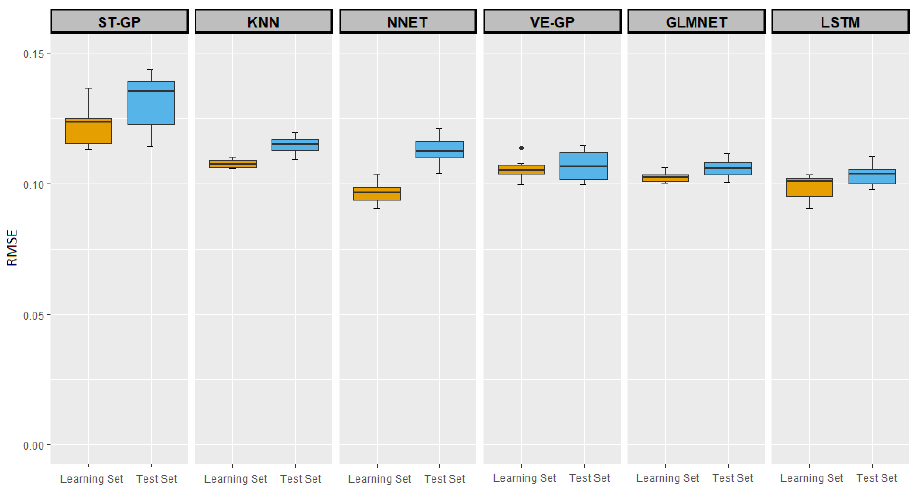
Figure 2. RMSEs on both the learning and test sets for the different algorithms. Learning results are plotted in yellow ( left ) and test results are plotted in blue ( right ) for each